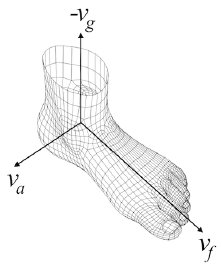
Figure 8. Foot-local coordinate